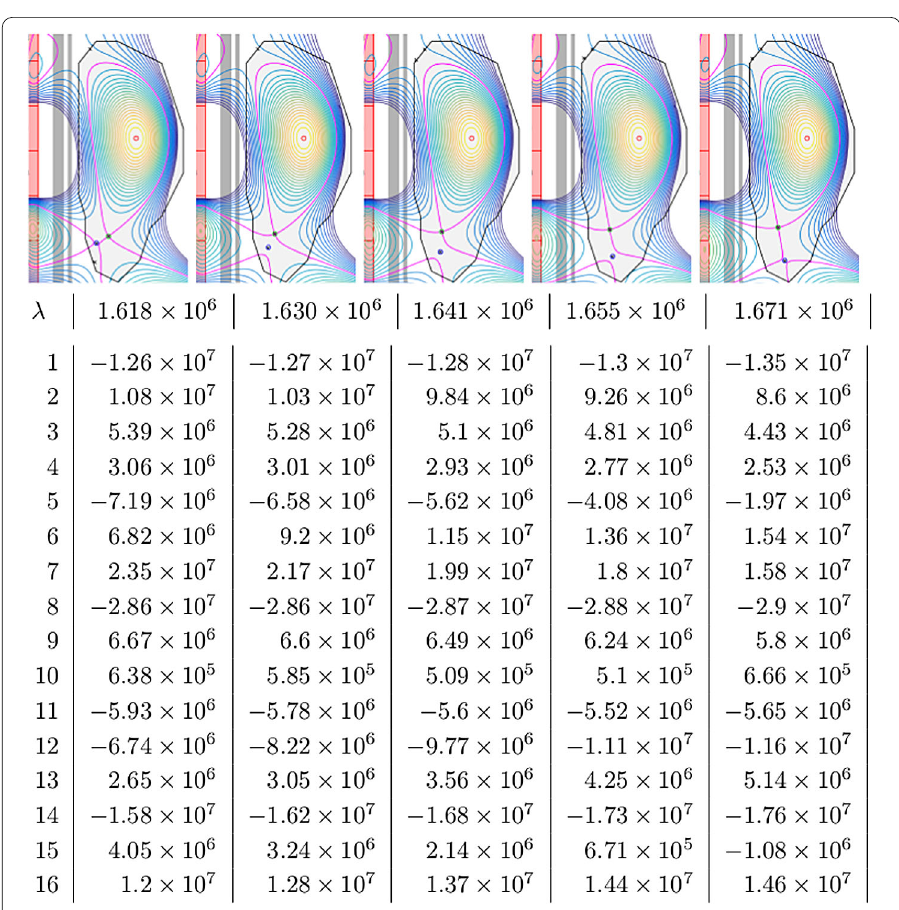
tions are useful as it is common practice to depart from snowflake-like configurations to tune manually coil currents that bring the equilibrium closer to an exact snowflake con- figuration. In the spirit of this idea we formulate a second optimal control problem (16) with the objective and regularization functionals